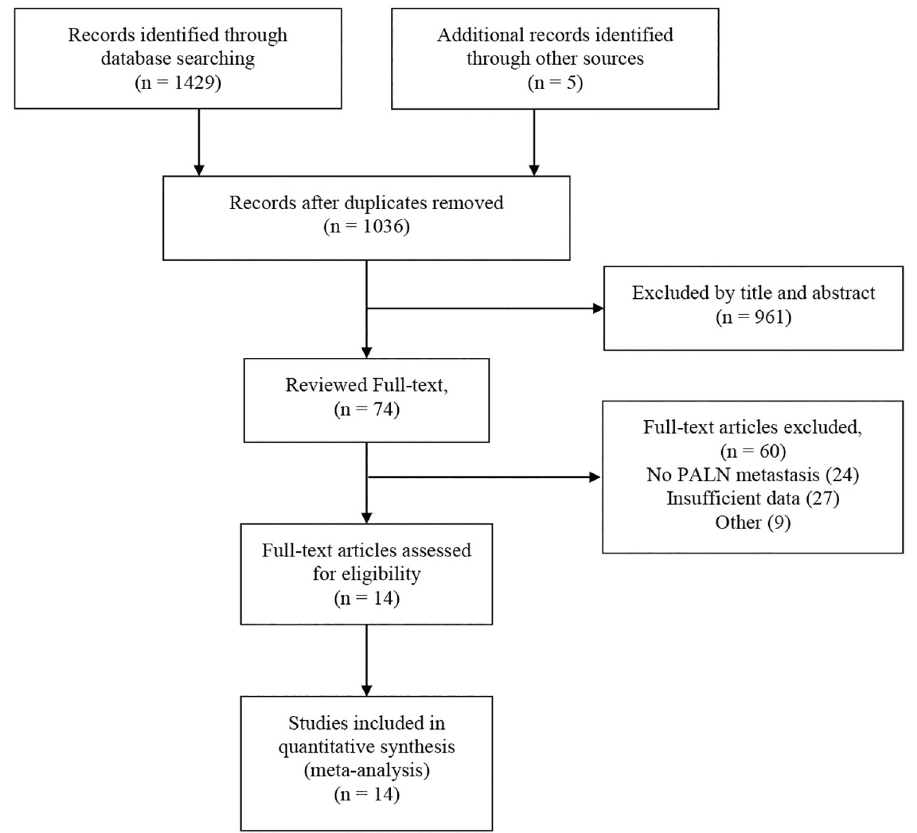
Fig 1. Flow diagram for the selection of studies in this meta-analysis. Abbreviations: PALN, para-aortic lymph nodes.